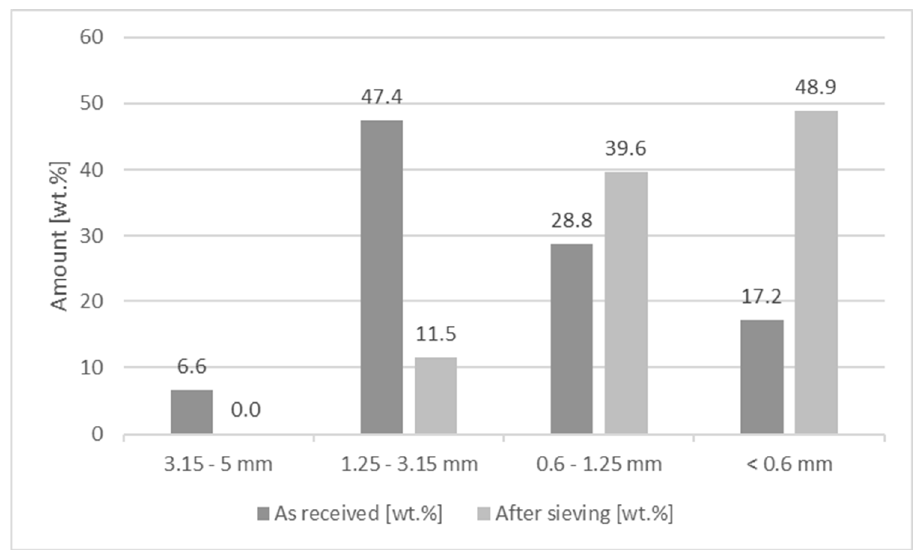
Figure 1. Processing of wheat straw particles for core and co-extruded layers: particle size distribution of particles before and after sieving in tumbler screening machine. Particles as received were used for the core, and particles after sieving in Condux mill with 1 mm sieve insert were used for the co-extruded layers.